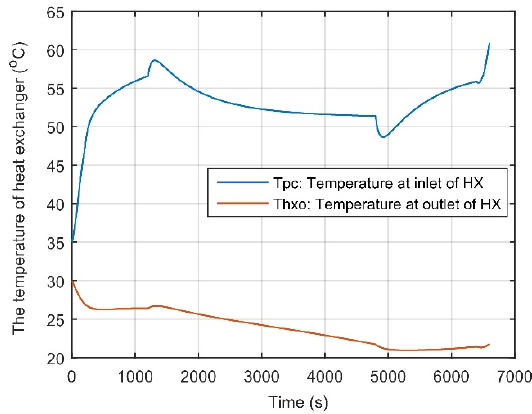
Figure 13. Inlet and outlet temperature of heat